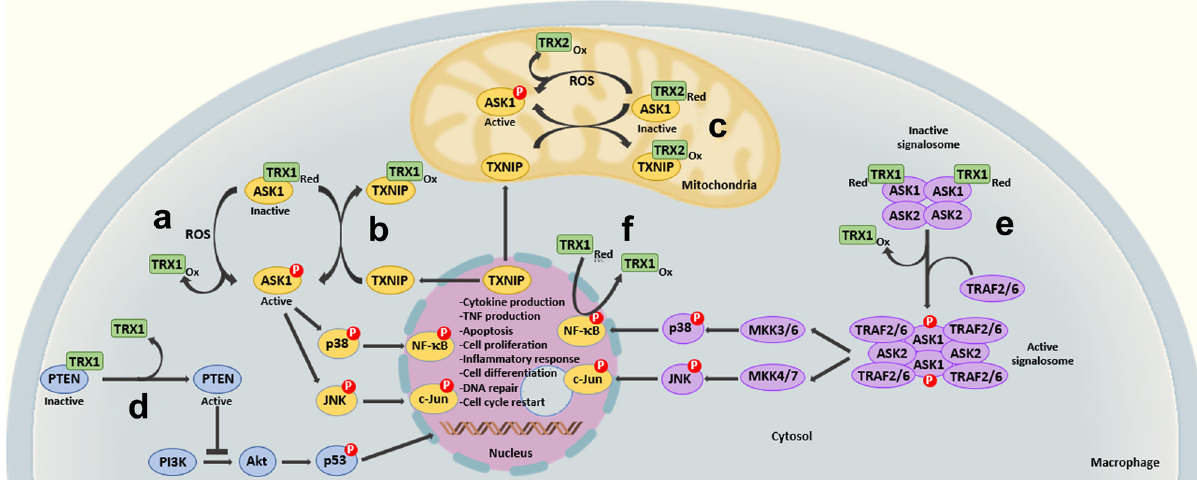
Figure 3: TRX1 as a regulator of di ff erent processes in macrophages. ( a ) Reduced TRX1, through any of its cysteines of its active site binds to a cysteine of the N - terminal end of the ASK1, hindering its autophosphorylation and activation. A high stress oxidizes TRX1 separating it from ASK1, which induces activation of the transcription factors nuclear factor kappa B ( NF - κ B ) and c - Jun ( involved in the in fl ammatory response and signaling of cytokines and growth factors ) . ( b ) The reduced TRX1 binds the TXNIP through the formation of a disul fi de bond between Cys32 of TRX1 and Cys247 of TXNIP, releasing it and activating ASK1 ( involved in apoptosis ) . ( c ) The regulation process of ASK1 is also performed in the mitochondrion but with the participation of an isoform of TRX ( TRX2 ) . ( d ) The reduced TRX1 binds the phosphatase and tensin homolog ( PTEN ) forming a disul fi de bond between the Cys32 of TRX and the Cys212 of PTEN, inactivating PTEN. The reduction of this disul fi de bond induces the release and activation of PTEN, which blocks the signaling cascade that activates the transcription factor p53 ( apoptosis, cell proliferation, and angiogenesis ) . ( e ) The capacity of TRX1 to bind to ASK1 allows it to be a regulator of the ASK1 signalo - some. The dissociation of TRX1 from the inactive signalosome causes ASK1 to autophosphorylate, activate, and recruit the proteins tumor necrosis factor type 2 receptor - associated protein 2 and 6 ( TRAF2/6 ) . This activates the ASK1 signalosome and the transcription factors NF - κ B and c - Jun. ( f ) Finally, TRX1 exerts a direct transcription regulating mechanism by reducing the p50 subunit of NF - κ B, inducing changes in the a ffi nity of the protein for